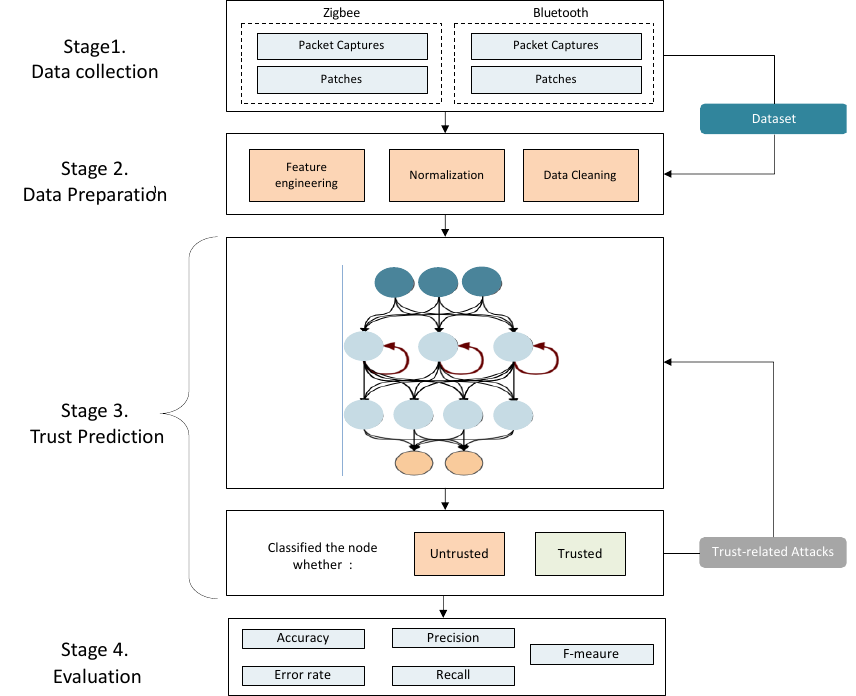
Figure 2. The proposed model. Table 3. Device deployment locations [38].